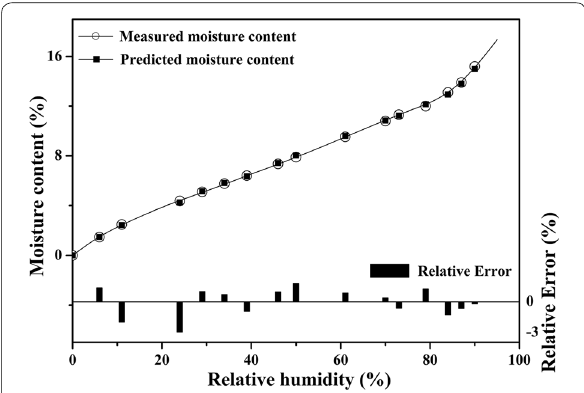
Fig. 8 Moisture sorption isotherm estimated by micro-FTIR forecasting model and that measured by DVS approach. Solid quadrate spot: MCs predicted using micro-FTIR forecasting